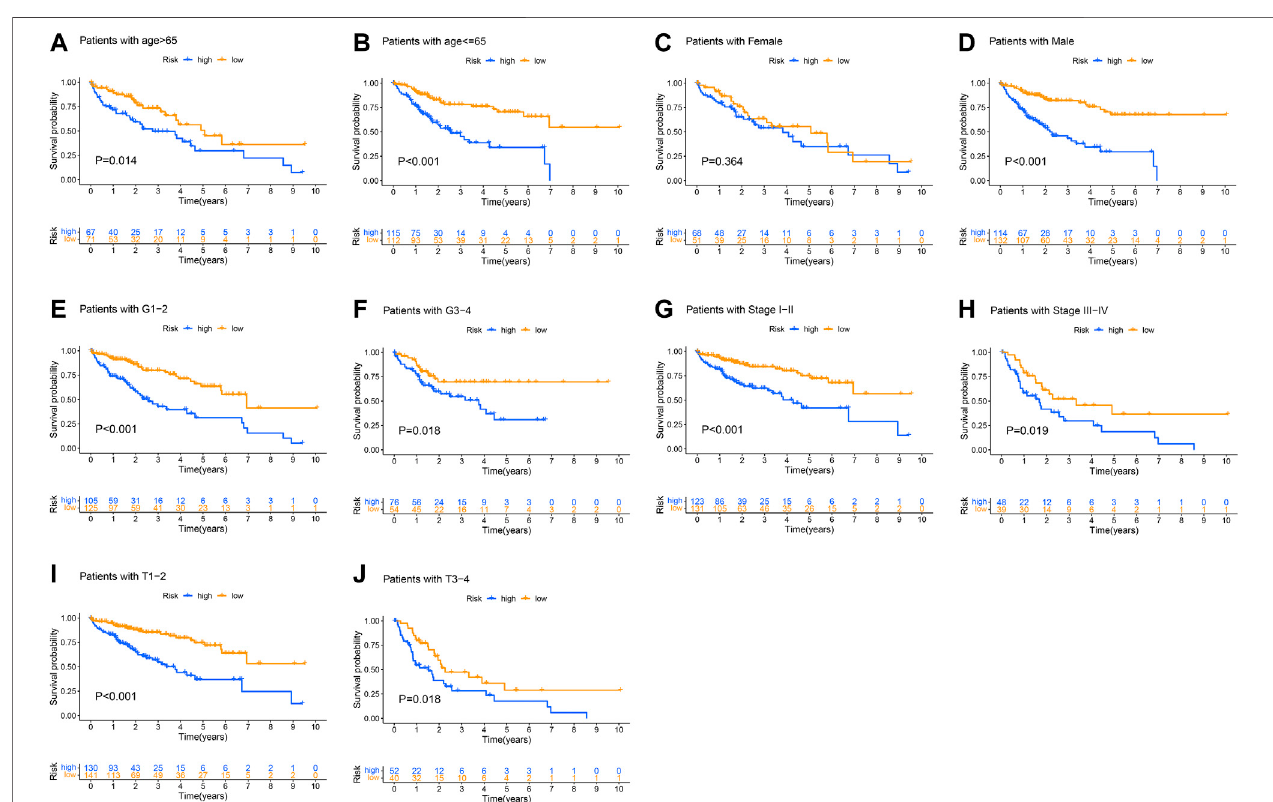
FIGURE6| Kaplan – Meiercurves wereperformedforpatients strati fi edbyclinicopathological featuresintheTCGA set.Impactofprognosticriskonoverallsurvival forpatientsyoungerthan65 yearsold (A) andolderthan65 yearsold (B) ;forfemale (C) andmalepatients (D) ;forpatientsinG1-2 (E) andG3-4 (F) ;forpatientsinstage I-II (G) and stage III-IV (H) ; and for patients in stage T1-2 (I) and stage T3-4 (J) .